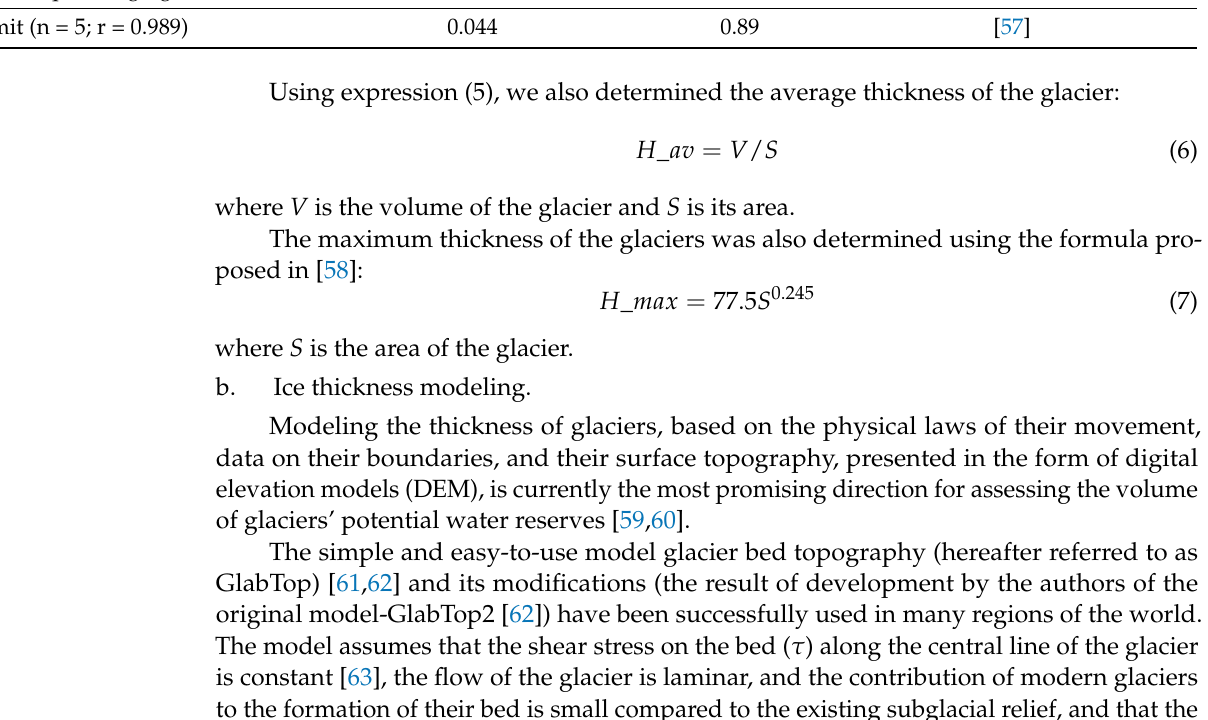
Table 4. Dependence between the area (S) and volume (V) of Altai glaciers as a function V = kS p . Morphological Type K p Source Valley (n = 46; r = 0.94) 0.0435 Cirque and cirque-hanging (n = 29; r =